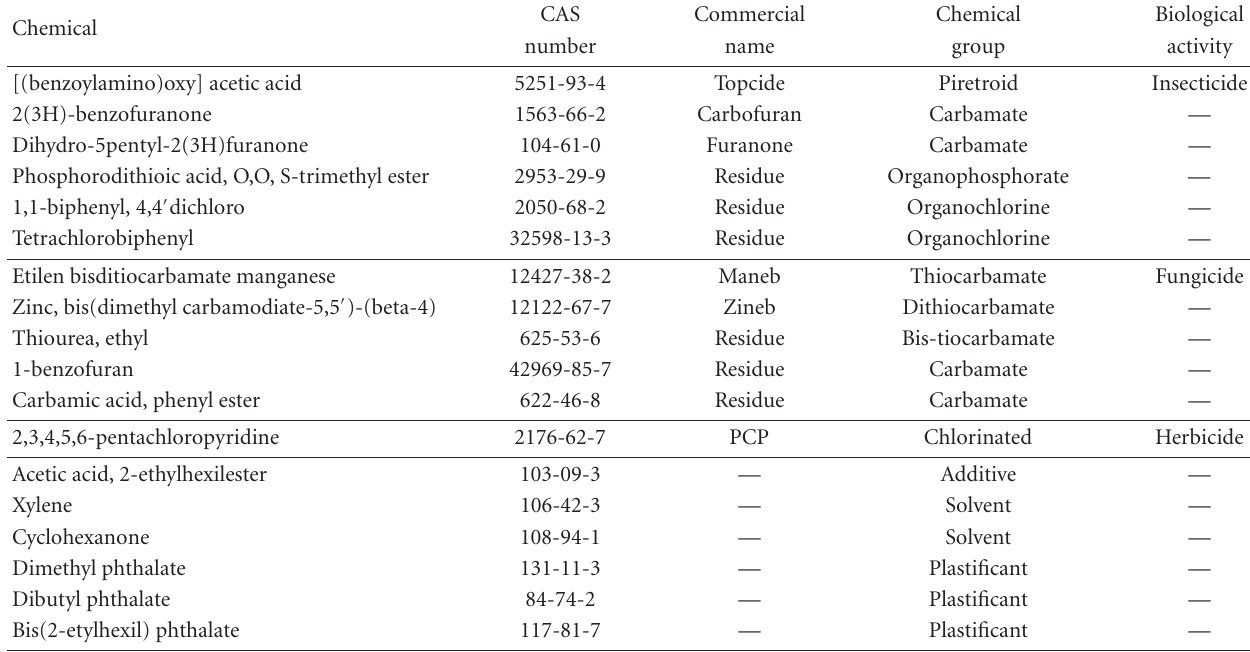
Table 4: Chemicals identified in the serum of